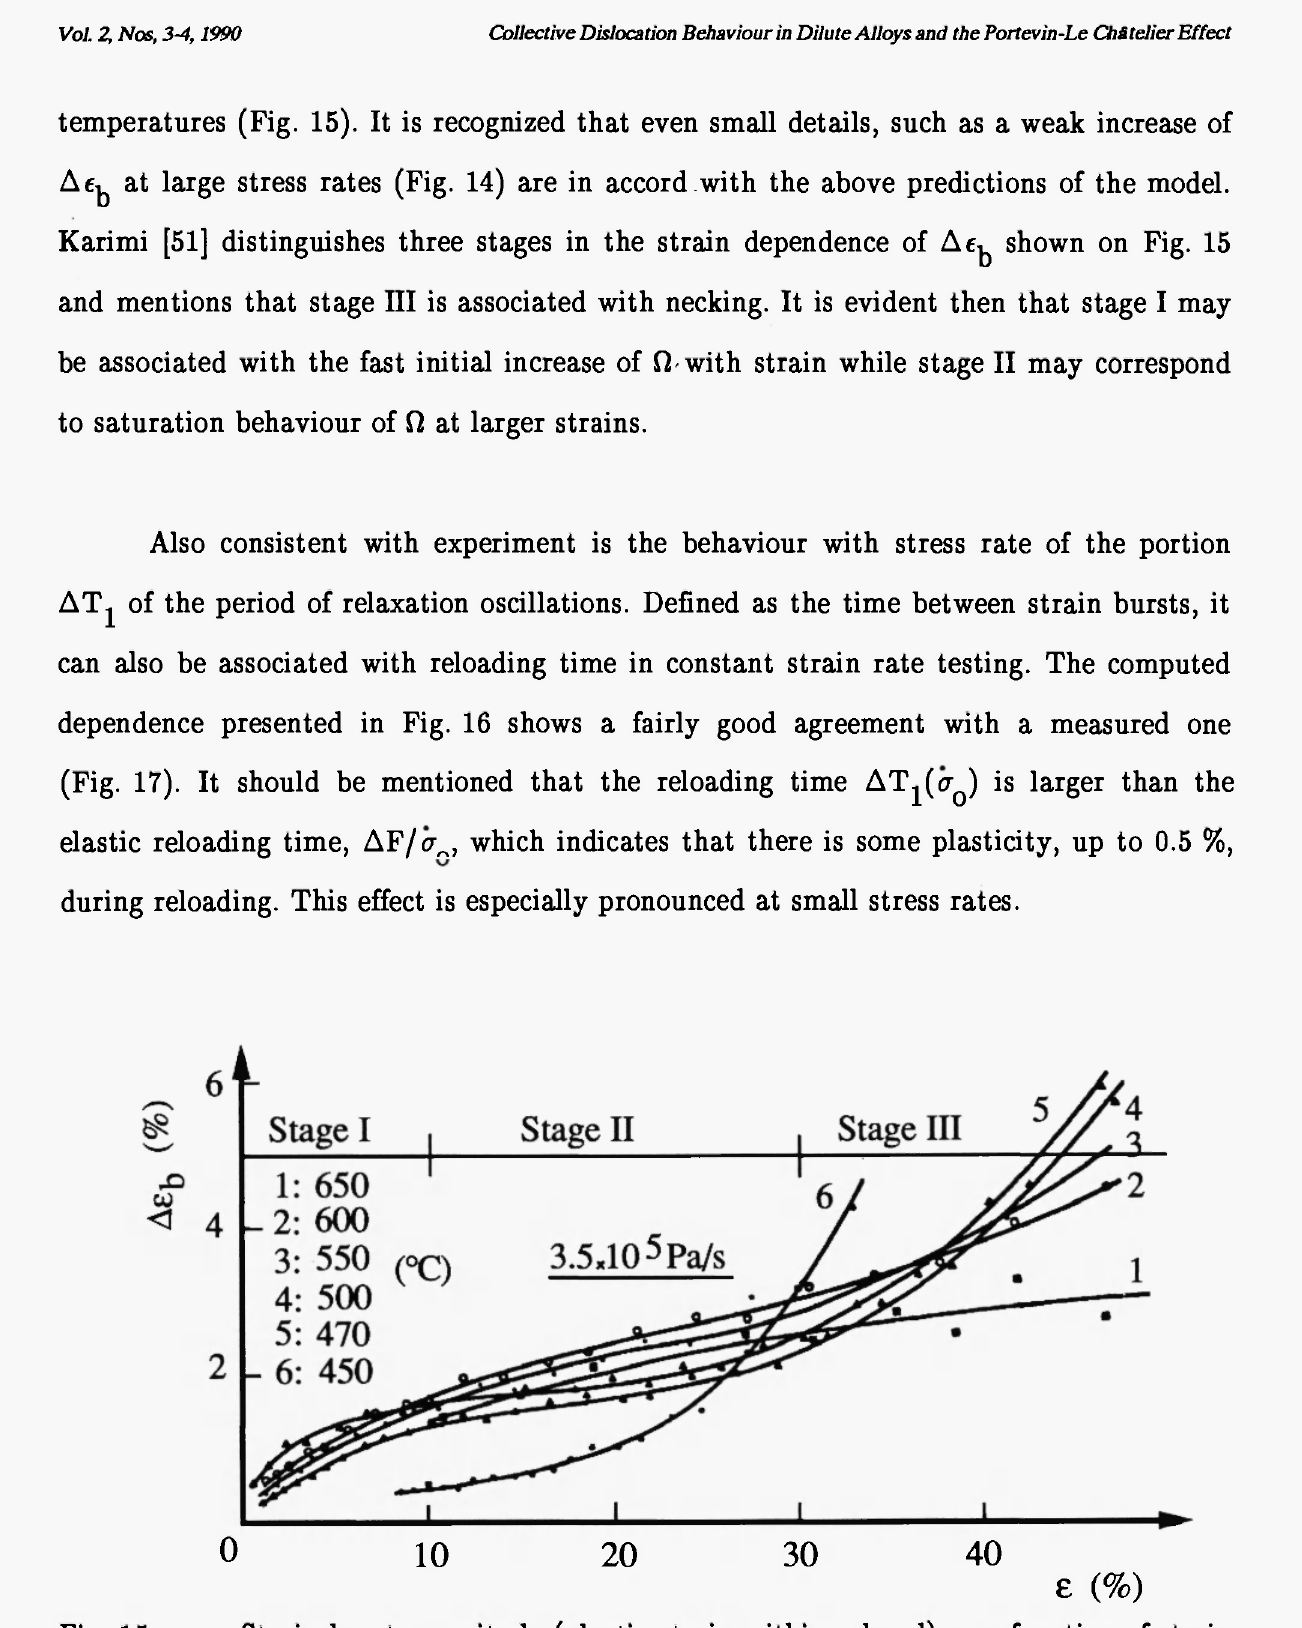
Fig. 15. Strain burst magnitude (plastic strain within a band) as a function of strain for a fixed stress rate and various temperatures in an austenitic stainless steel. (After Karimi